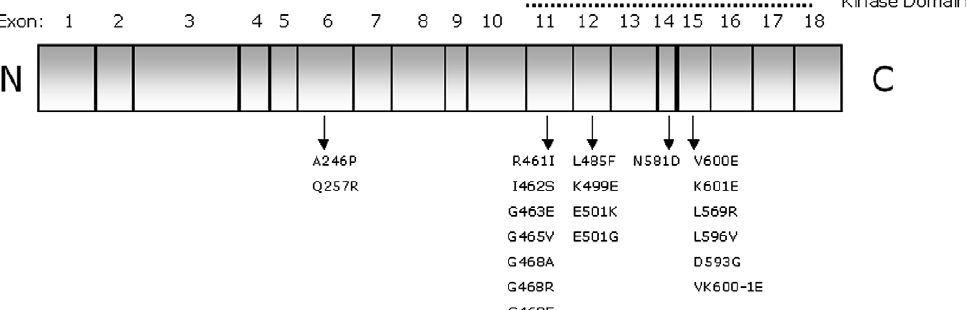
Fig. 2. Spectrum of BRAF mutations.